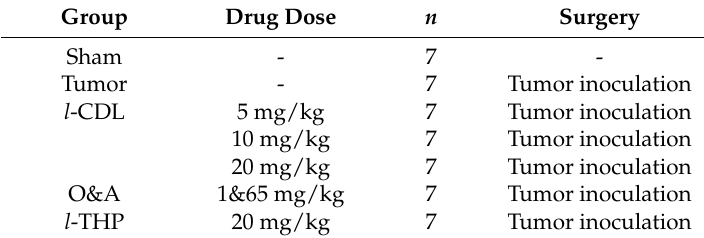
Table 1. The experimental